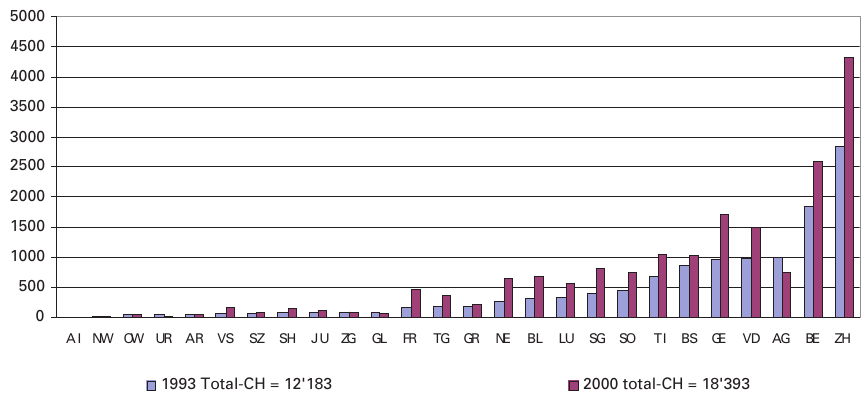
Number of methadone treat- ments per canton in Switzerland in 1993 and 2000